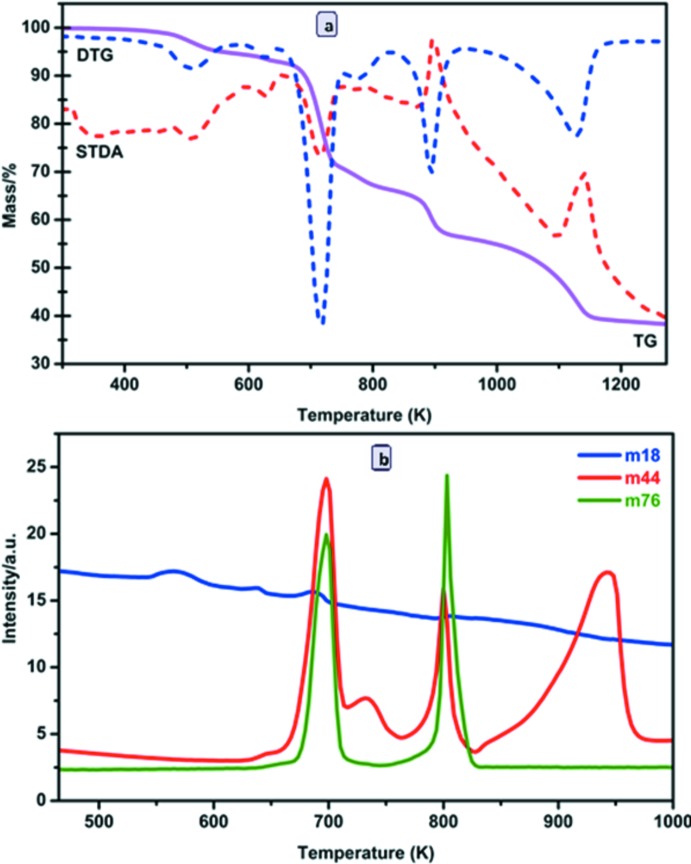
(a) TG–DTG–SDTA curves and (b) m/z 18 (H2O), m/z 44 (CO2) and m/z 76 (C6H4) MS signals for (I).